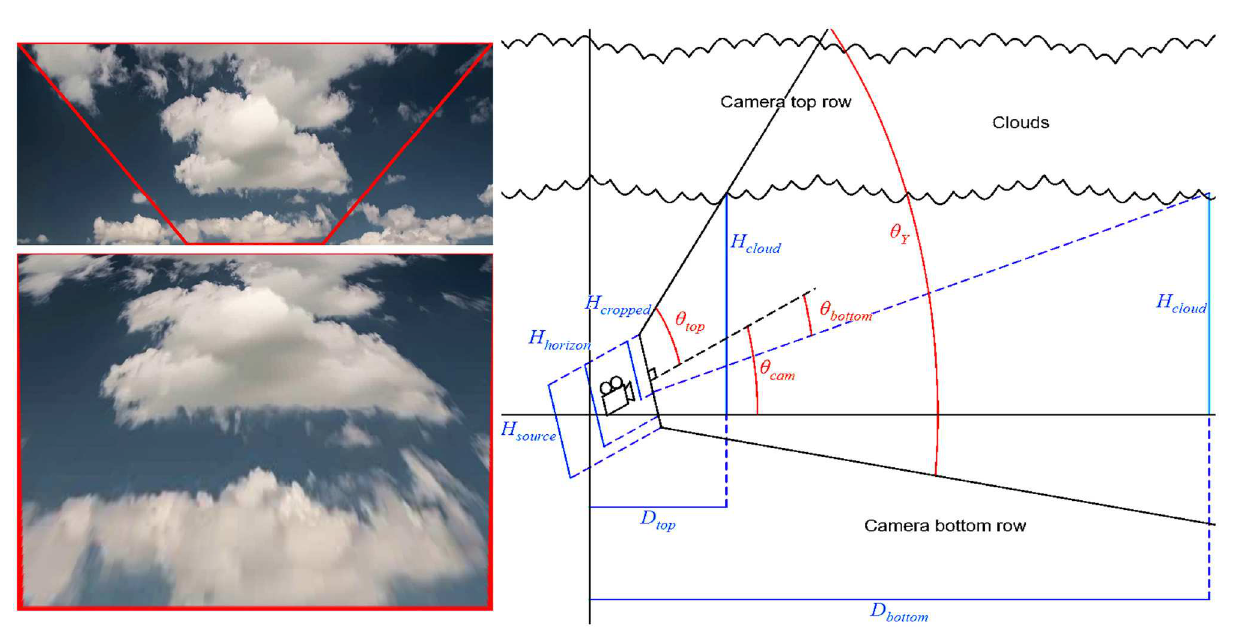
FIGURE2 λ cropped with its four points forming the corners of a convex isosceles trapezium (top left) . λ cropped after perspective correction into λ corrected (bottom left) . Note how the bottom corners of the trapezium have been stretched to the bottom corners. Side-view visual representation of the calculations of Equations (1)–(3), which later leads to determining the final two points in λ cropped (right) .